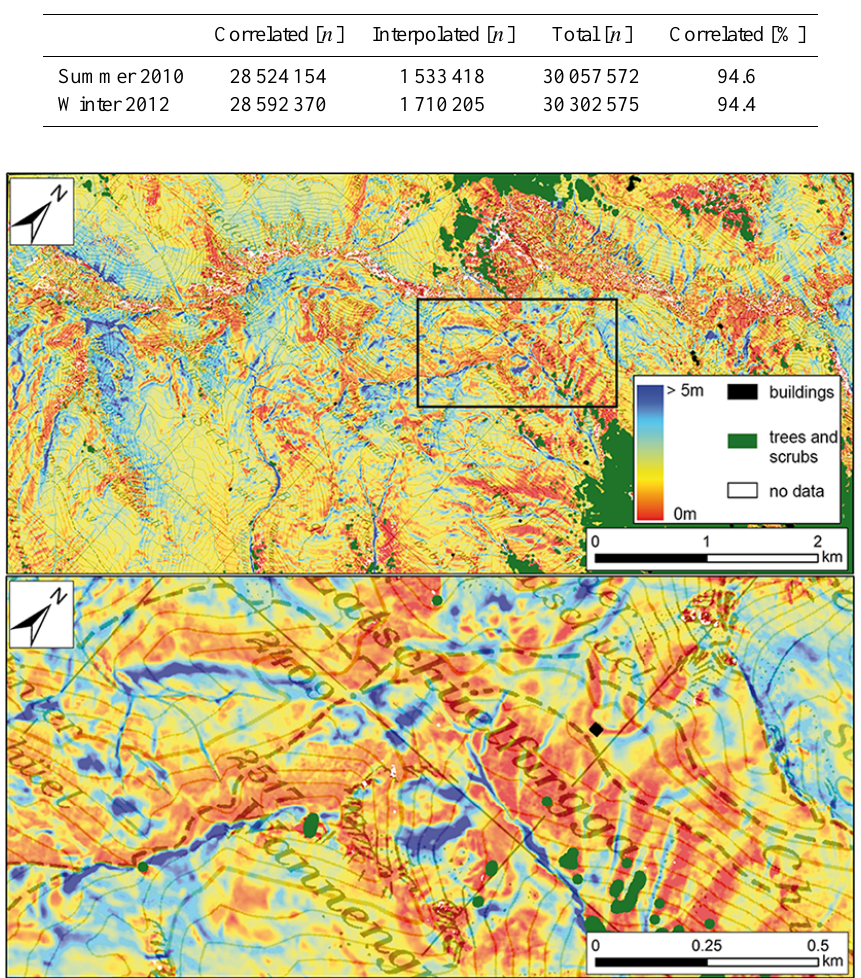
Figure 4. Snow depth map of the entire Wannengrat area (top, see Fig. 1. for orientation) and a close-up view of the area where the reference data was acquired (bottom). Traps for wind-blown snow, cornices and deposits from past avalanche events can be identified by the highest snow depth